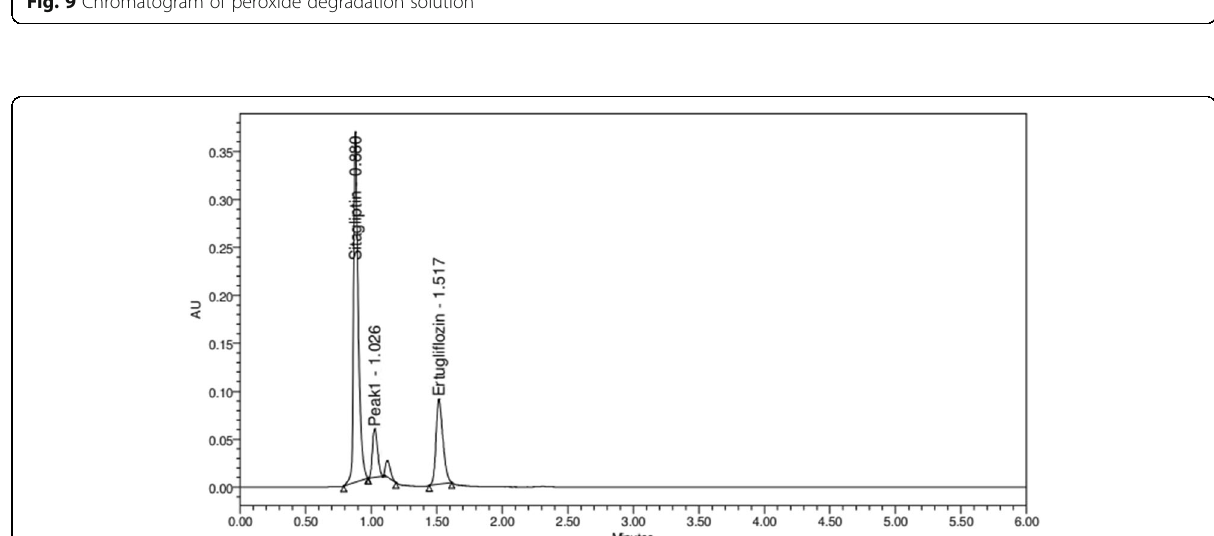
Fig. 10 Chromatogram of thermal degradation